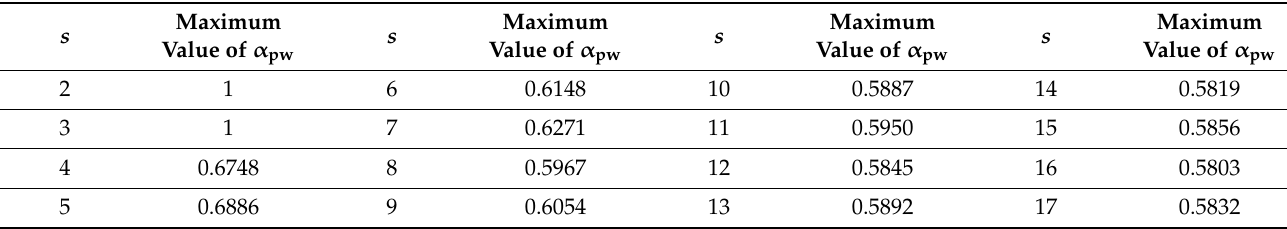
Table 2. Maximum values of the pole-arc